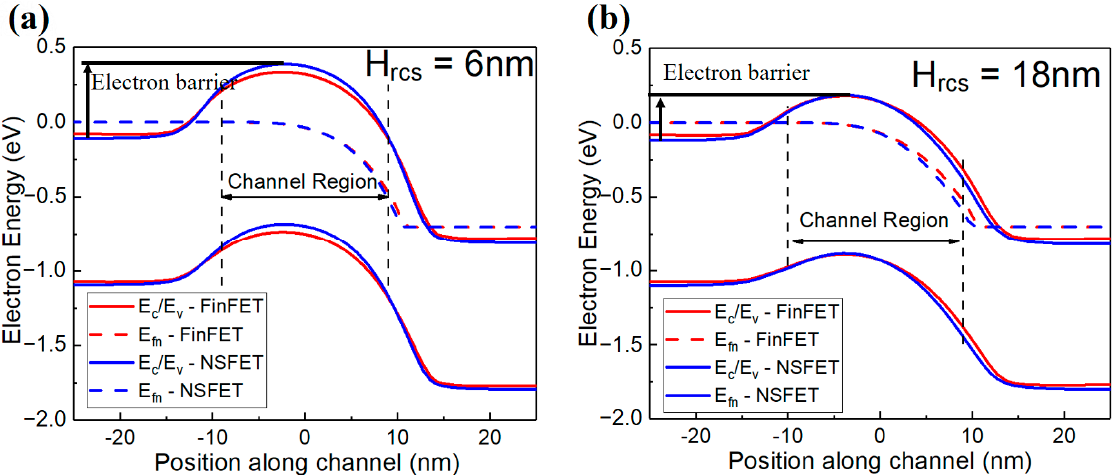
9 of 12 Figure 7. I off of Fin and NS FETs as a function of H rcs . Inset: Gate controllability demonstration of sub-Fin region and bottom parasitic channel. As shown in this Figure 8a, the electron barrier in the parasitic channel of NSFET is higher than that of FinFET due to the additional electrostatic control from the bottom gate electrode. The position of 0 nm corresponds to the center of the channel. Therefore, the source-to-drain leakage current of NSFET is 23% less than that of FinFET for 6 nm H rcs . How- ever, with the continuous increase in the H rcs , the leakage path shifts away from the top of the STI, as shown in Figure 6c,d. In the meantime, more phosphorus inevitably diffuses into